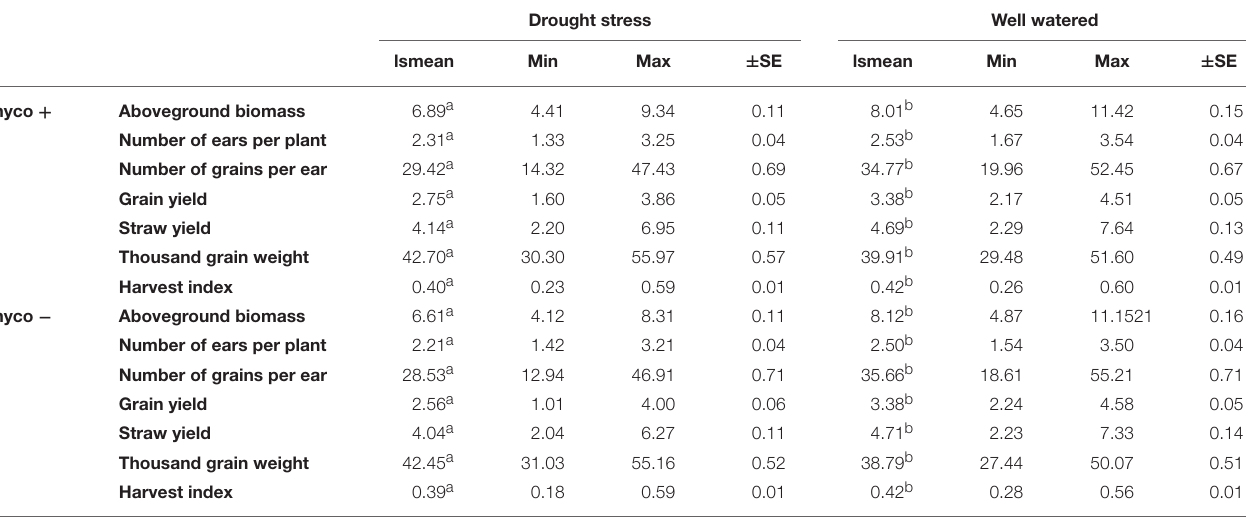
TABLE 4 | Least square means (lsmean), minimum (Min), maximum (Max) and standard error ( ± SE) for aboveground biomass (BM), number of ears per plant (EN), number of grains per ear (GN), grain yield (GY), straw yield (SY), thousand grain weight (TGW), and harvest index (HI) under drought stress and well watered conditions in the presence (myco + ) and absence (myco − ) of mycorrhizae for 94 wheat genotypes evaluated in two